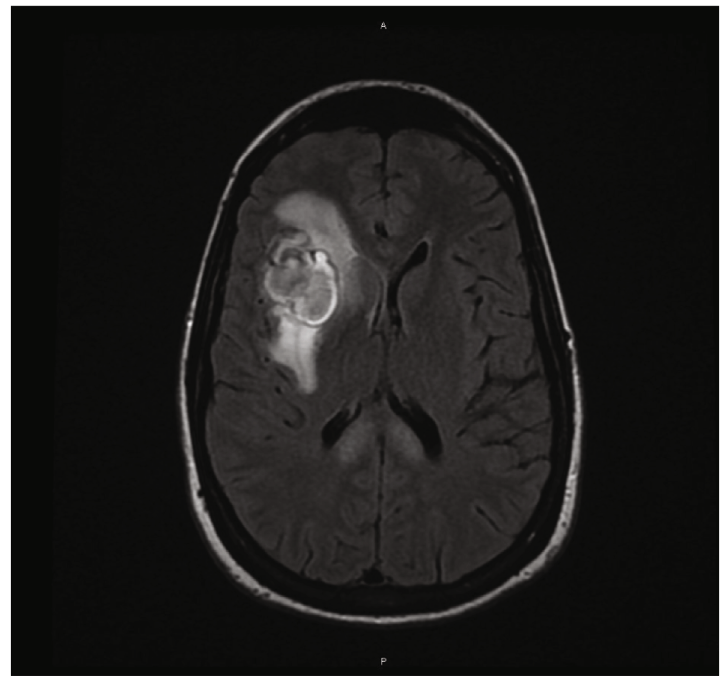
Figure 2: Intraparenchymal hemorrhage of the right frontal lobe on axial T2 fl are